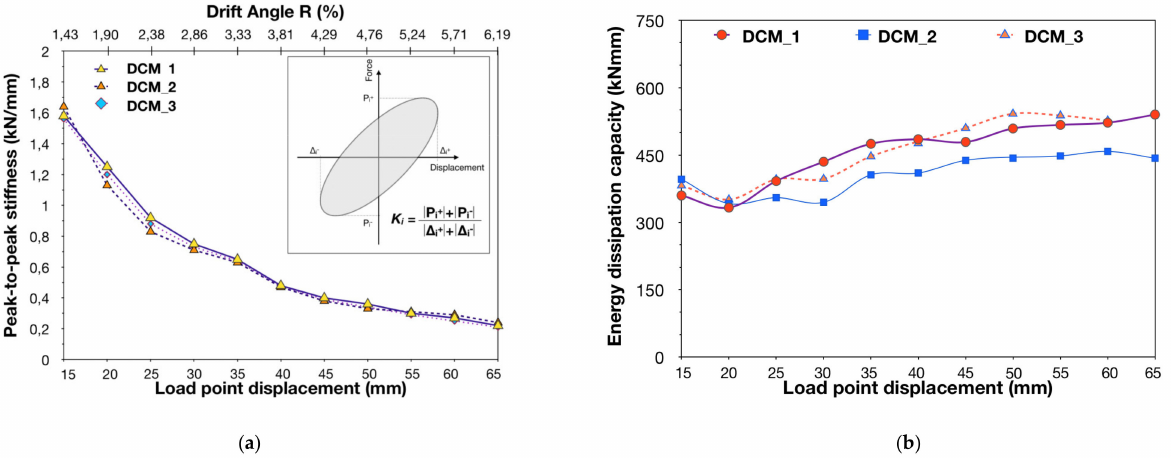
Figure 4. Plots of ( a ) peak-to-peak stiffness versus displacement and ( b ) energy dissipation capacity versus displacement of the subassemblages DCM _1, DCM _2, and DCM